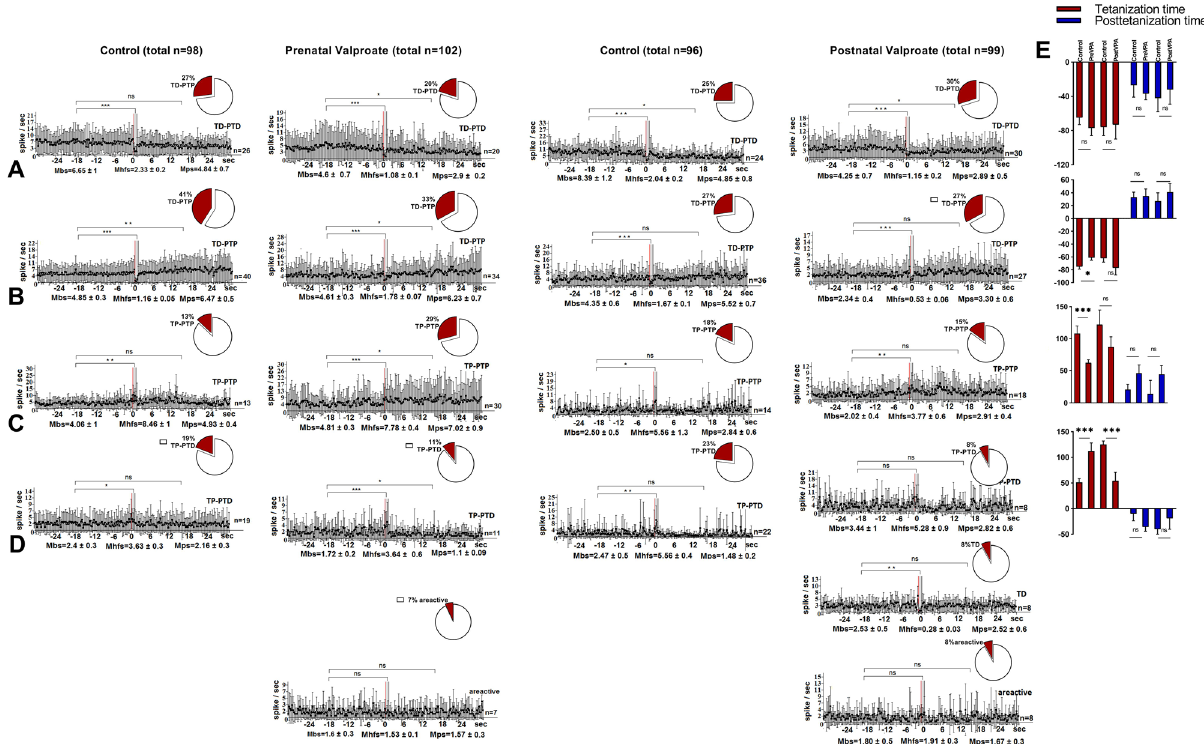
Figure 6. Electrophysiological changes in form of time histograms of peri-stimulus average spike frequency in neurons of amygdala to high-frequency stimulation of hippocampus after prenatal and postnatal VPA administration. The time histograms of peri-stimulus average spike frequency in neurons of amygdala are illustrated in the figure. The mean peri-stimulus frequency diagrams built on the basis of pre-stimulus and post-stimulus manifestations of spike activity of single amygdala neurons to high-frequency stimulation of hippocampus in a real time 30 s before stimulation (Mbs), 30 s post-stimulation (Mps) and during high- frequency stimulation (Mhfs), exhibiting the specified types of response: ( A ) TD-PTD, ( B ) TD-PTP, ( C ) TP-PTP, ( D ) TP-PTD, and nonreactivity in the VPA treated groups. The data are presented as mean ± SD; n = number of neurons. The statistical significance from baseline (Mbs) was estimated acording to the unpaired Student’s t-test , *** p < 0.001, ** p < 0.01, * p < 0.05, ns -non significant. ( E )The bar diagrams show the average % change relative to the baseline (Mbs, zero level) in responses of tetanization time (red) and post-tetanization time (blue) in control vs. VPA treated groups in the population of neurons with a given type of response. Statistical significance was calculated using Fisher’s exact test, * p <